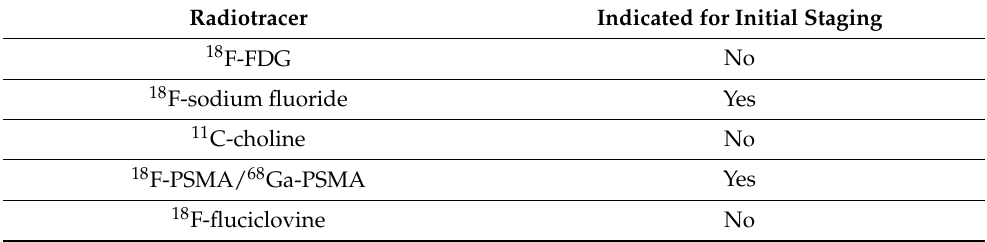
Table 1. List of FDA-Approved Radiotracers for Prostate Cancer. Radiotracer Indicated for Initial